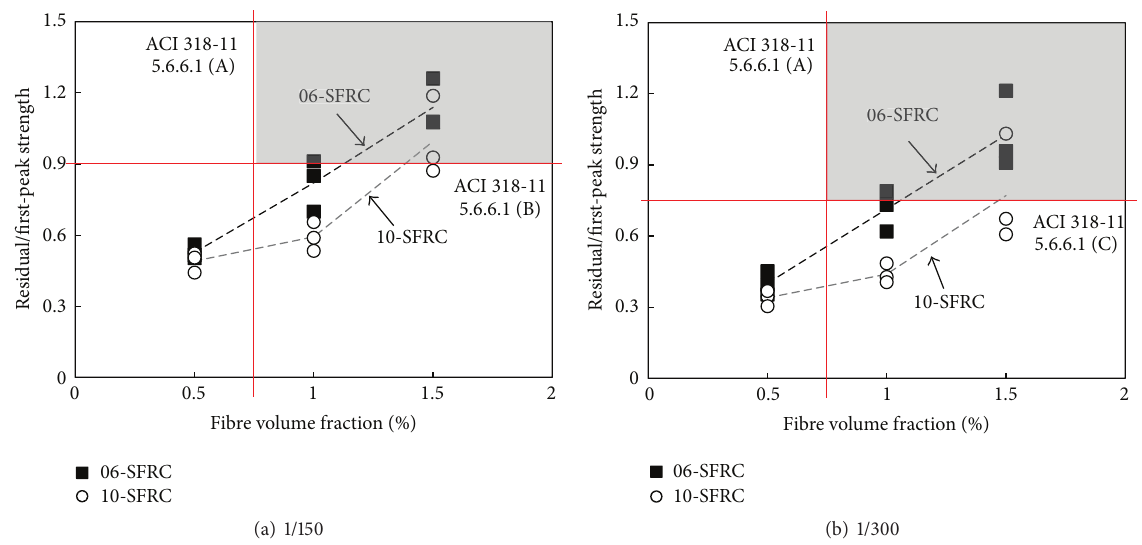
Figure 3: Flexural performance of HP-SFRC prisms in accordance with ASTM C 1609.